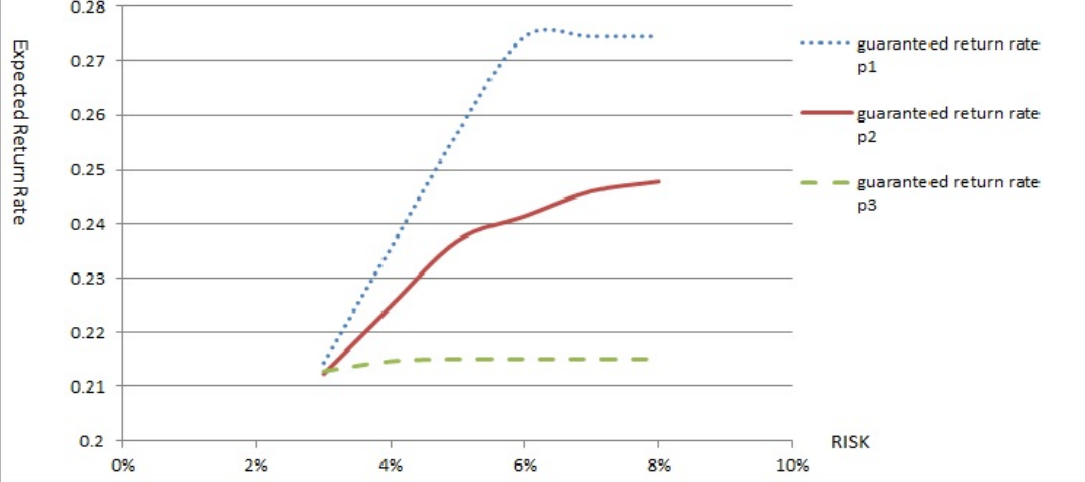
Figure 1. The comparisons between different guaranteed return rates.